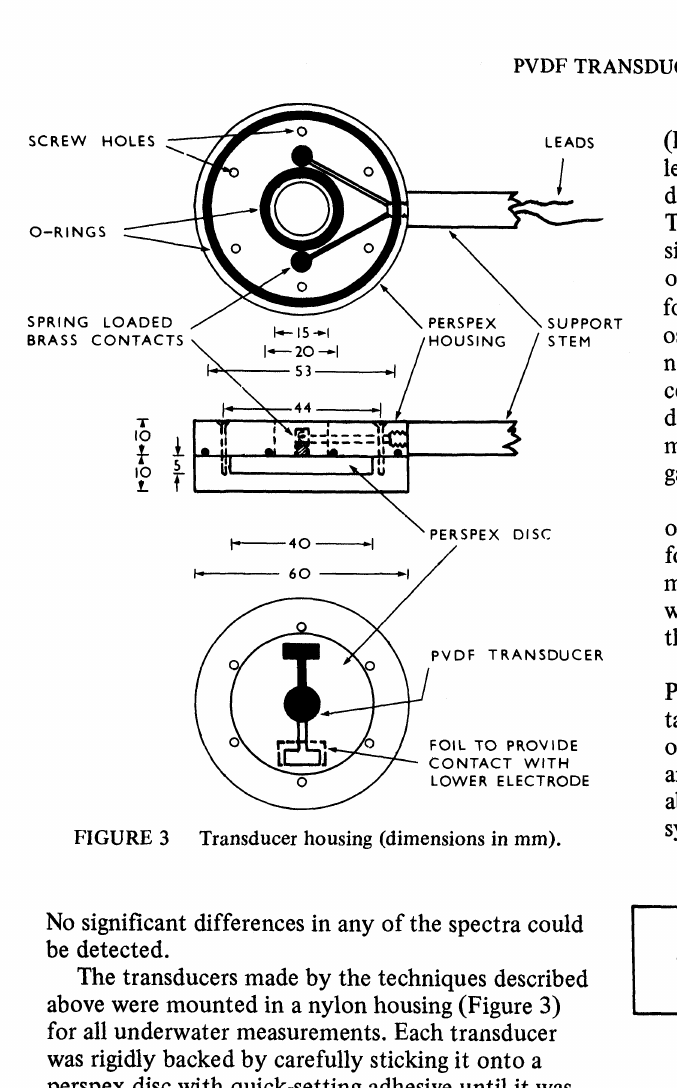
FIGURE 3 Transducer housing (dimensions in